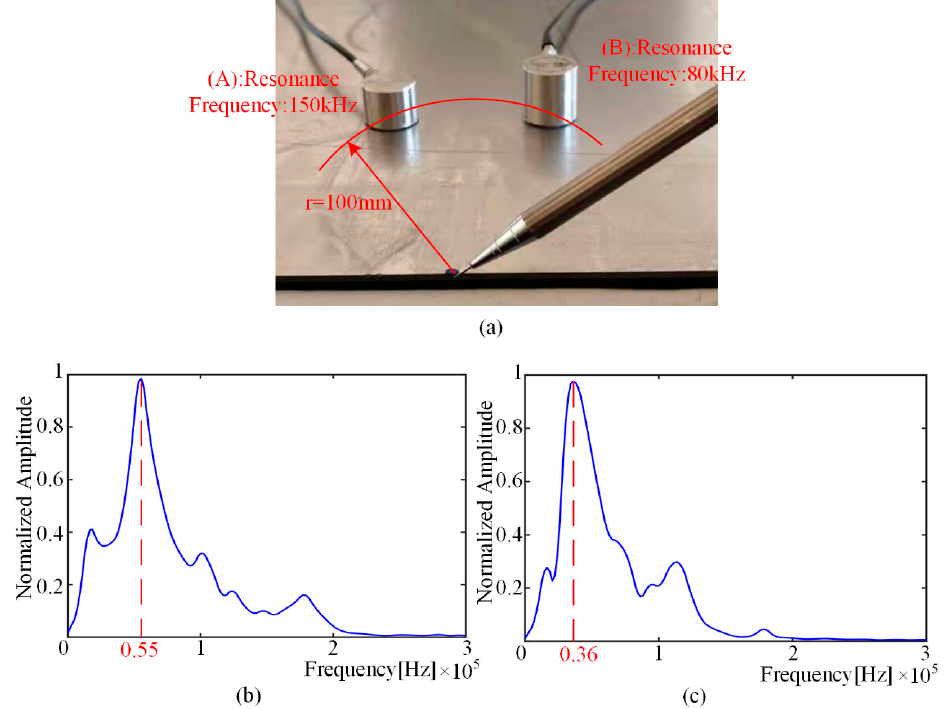
Figure 9. The experiment with sensors of different resonant frequencies: ( a ) experiment setup; ( b ) the frequency spectrum of the signal received by sensor A; ( c ) the frequency spectrum of the signal received by sensor B.